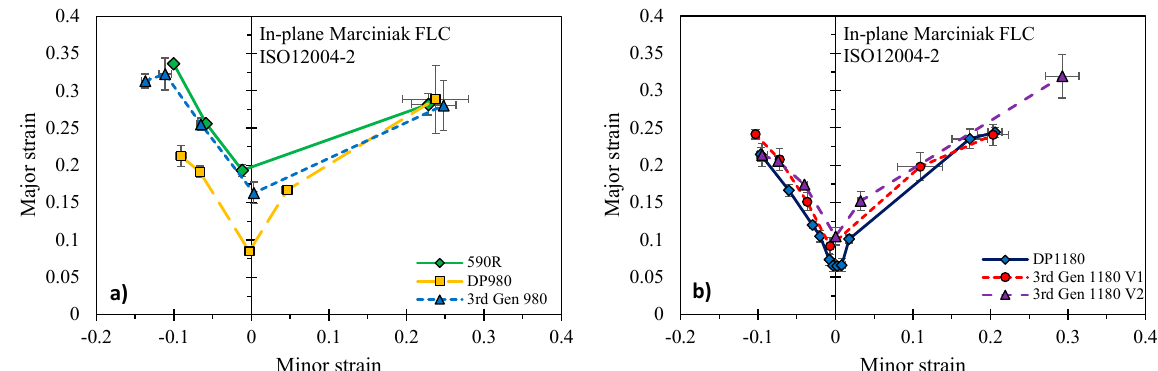
Figure 22. In-plane forming limit using the ISO12004-2 standard for the 590R, DP980, and 3rd Gen 980 ( a ) and the 3rd Gen 1180 V1, V2, and the DP1180 ( b ).